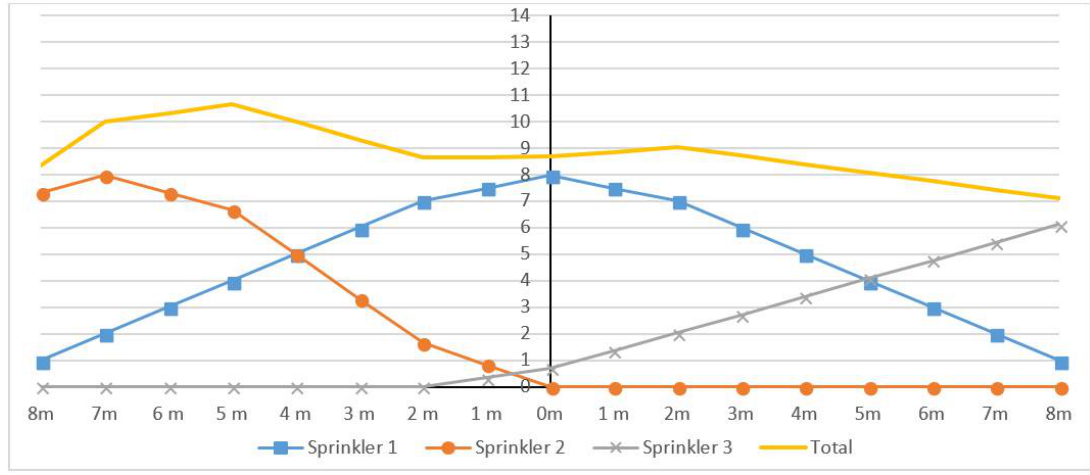
Figure 8. Water depth in mm and distribution uniformity pattern around the irrigated circle of a CHL sprinkler with 8 m distance of throw.